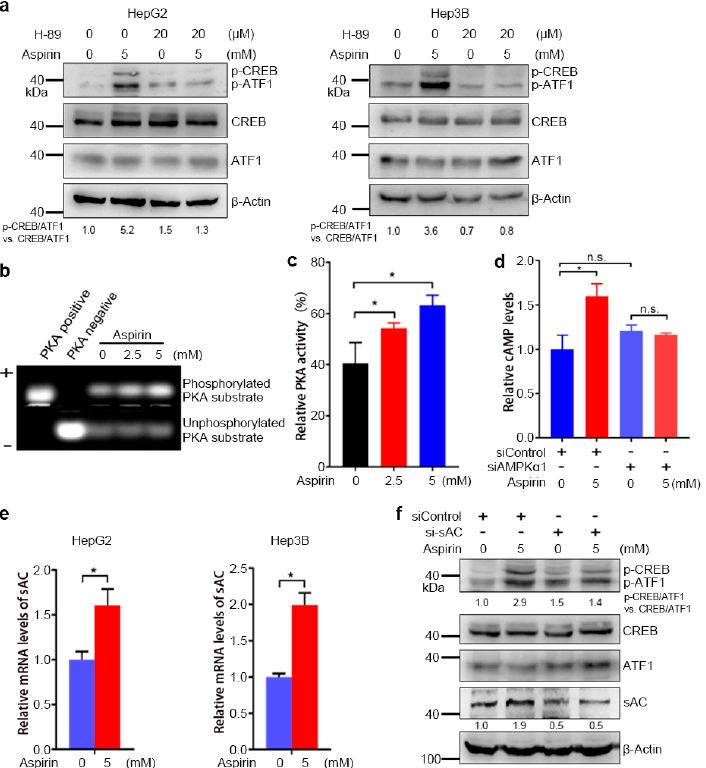
Figure 2. Aspirin activates the sAC–cAMP–PKA–CREB/ATF1 pathway through AMPK. ( a ) HepG2 and Hep3B cells were incubated with H-89 and/or aspirin for 32 h, followed by western blot analysis with indicated antibodies. The relative levels of p-CREB/ATF1 normalized to total CREB/ATF1 were shown. ( b ) HepG2 cells were treated with aspirin for 48 h, followed by PKA kinase assay. The phosphorylated and unphosphorylated PKA substrate kemptide were separated in agarose gel. The positive and negative controls were shown. ( c ) The phosphorylated band in b was cut and dissolved, followed by detecting the fluorescence values. The PKA activity in the PKA-positive group was set as 100%. The PKA activity in aspirin-treated and vehicle-treated groups was plotted. Values represent means ± SD ( n = 3). *, p < 0.05. ( d ) HepG2 cells were transfected with siControl or siAMPK α 1 and treated with or without aspirin for 1 h, followed by cAMP assays. The relative cAMP levels were plotted. Values represent means ± SD ( n = 3). *, p < 0.05. n.s., not significant. ( e ) HepG2 and Hep3B cells were treated with aspirin for 48 h, followed by real-time RT–PCR analysis of sAC transcription. The relative mRNA levels were plotted. Values represent means ± SD ( n = 3). *, p < 0.05. ( f ) HepG2 cells were transfected with siControl or si-sAC and treated with or without aspirin for 32 h, followed by Western blot analysis with indicated antibodies. The relative levels of p-CREB/ATF1 normalized to total CREB/ATF1, and relative levels of sAC normalized to β -actin were